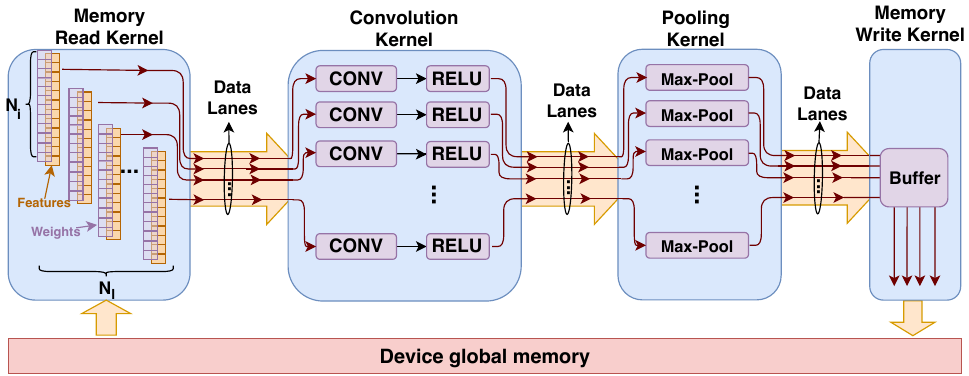
Figure 6. Detailed demonstration of vectorized input data and weights and the concept of computation lanes in pipelined